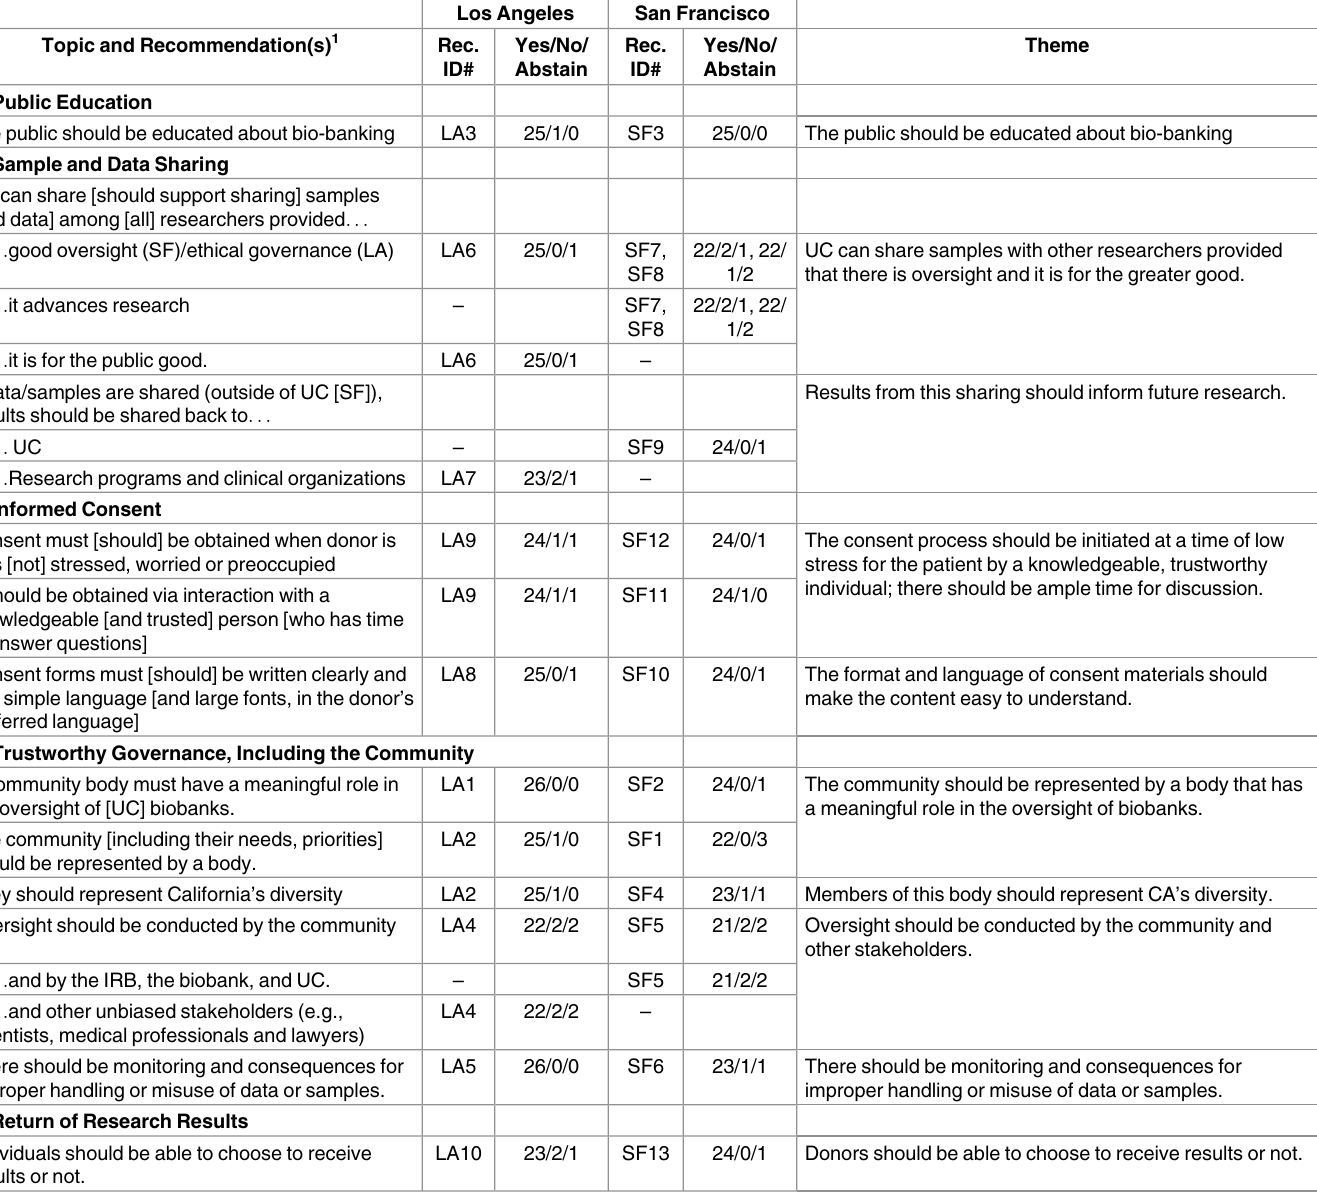
Table 2. Analysis of highly supported cross-site recommendations from